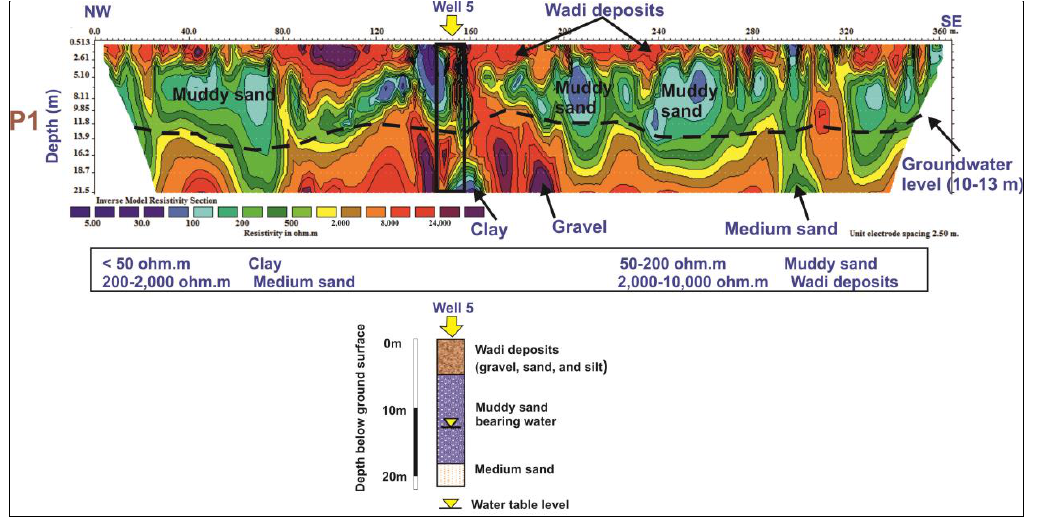
Figure 13. Interpreted 2D inverted resistivity model of profile No 1. Four distinct geoelectric zones were identified based on the resistivity data.